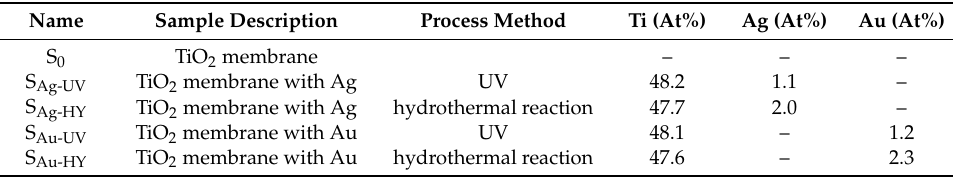
Table 1. Processes for TiO 2